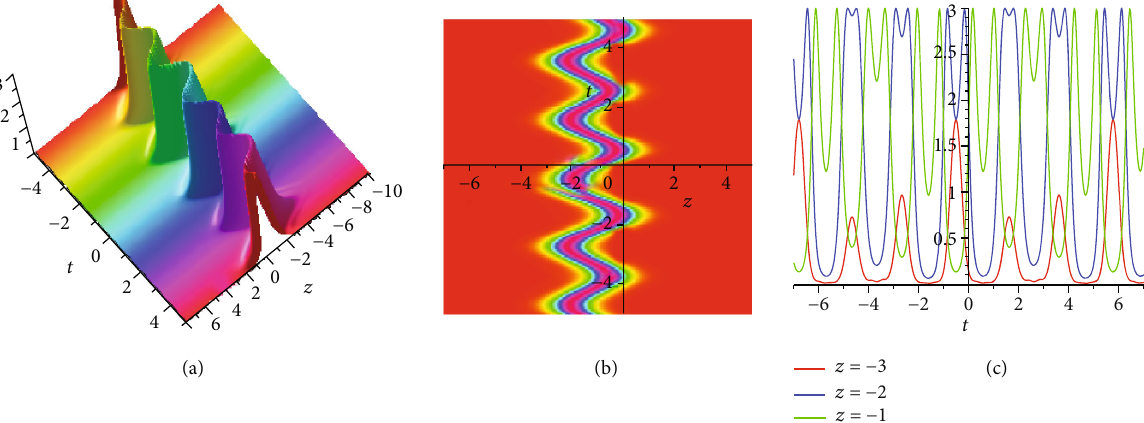
Figure 6: Plots of interaction lump with two solitons (49).